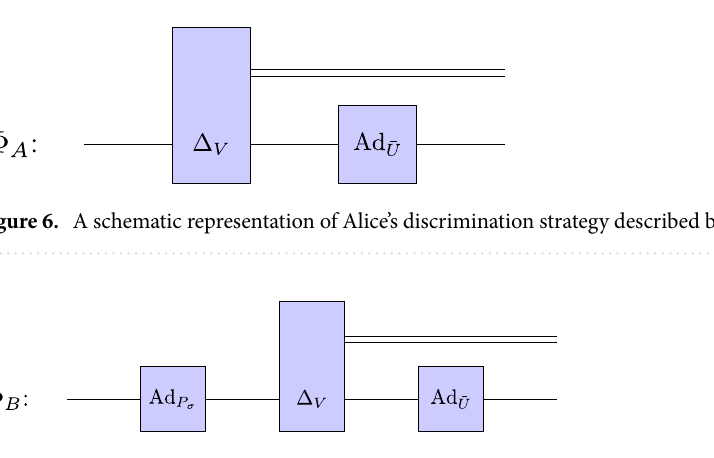
Figure 7. A schematic representation of Bobs’ discrimination strategy described by Eq.